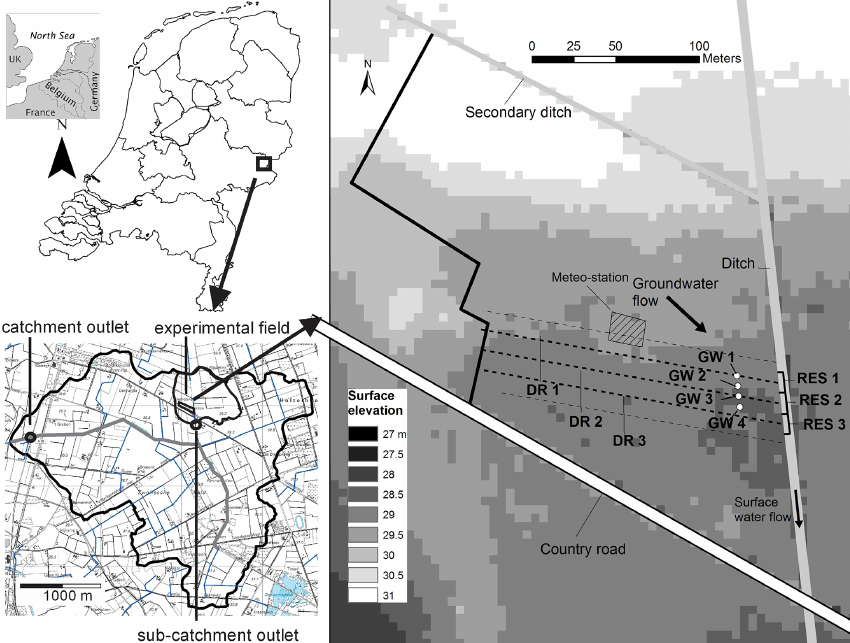
Figure 1. Location of the Hupsel catchment and the experimental field. The catchment map shows the sub-catchment outlet and catchment outlet. The field map shows the three measured tube drains (DR), the four groundwater wells (GW) and the location of the in-stream reservoirs (RES). The direction of the groundwater flow is taken from Rozemeijer et al.